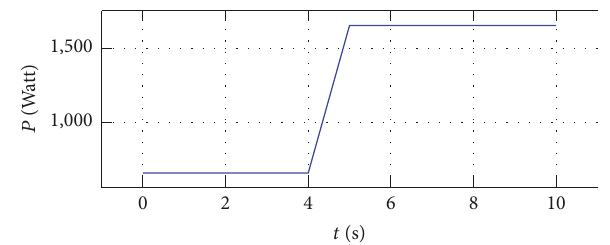
Figure 9: Profile of single family household